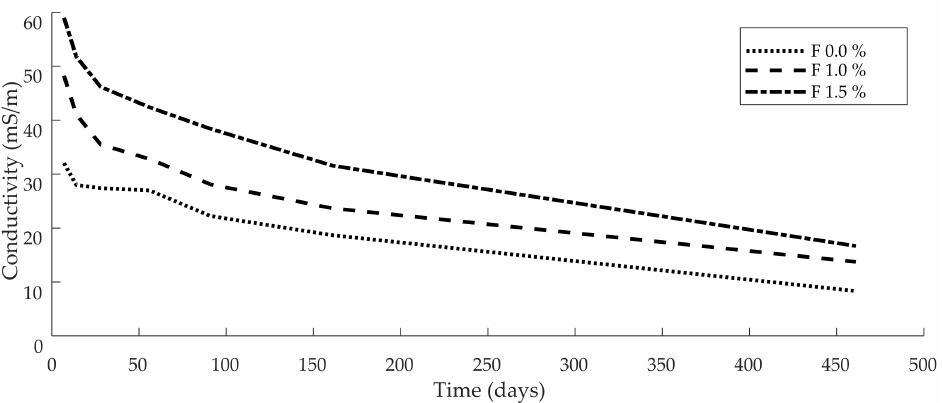
Figure 1. Conductivity of the SLWAC in time with different amounts of